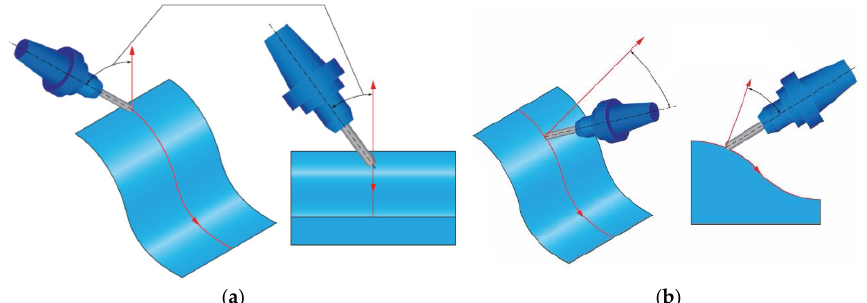
Figure 3. Tool axis inclination angle β f in feed direction [2,14] ( a ) pulled tool ( b ) pushed tool (d—tool diameter, d eff —effective tool diameter, a p —axial depth of cut).